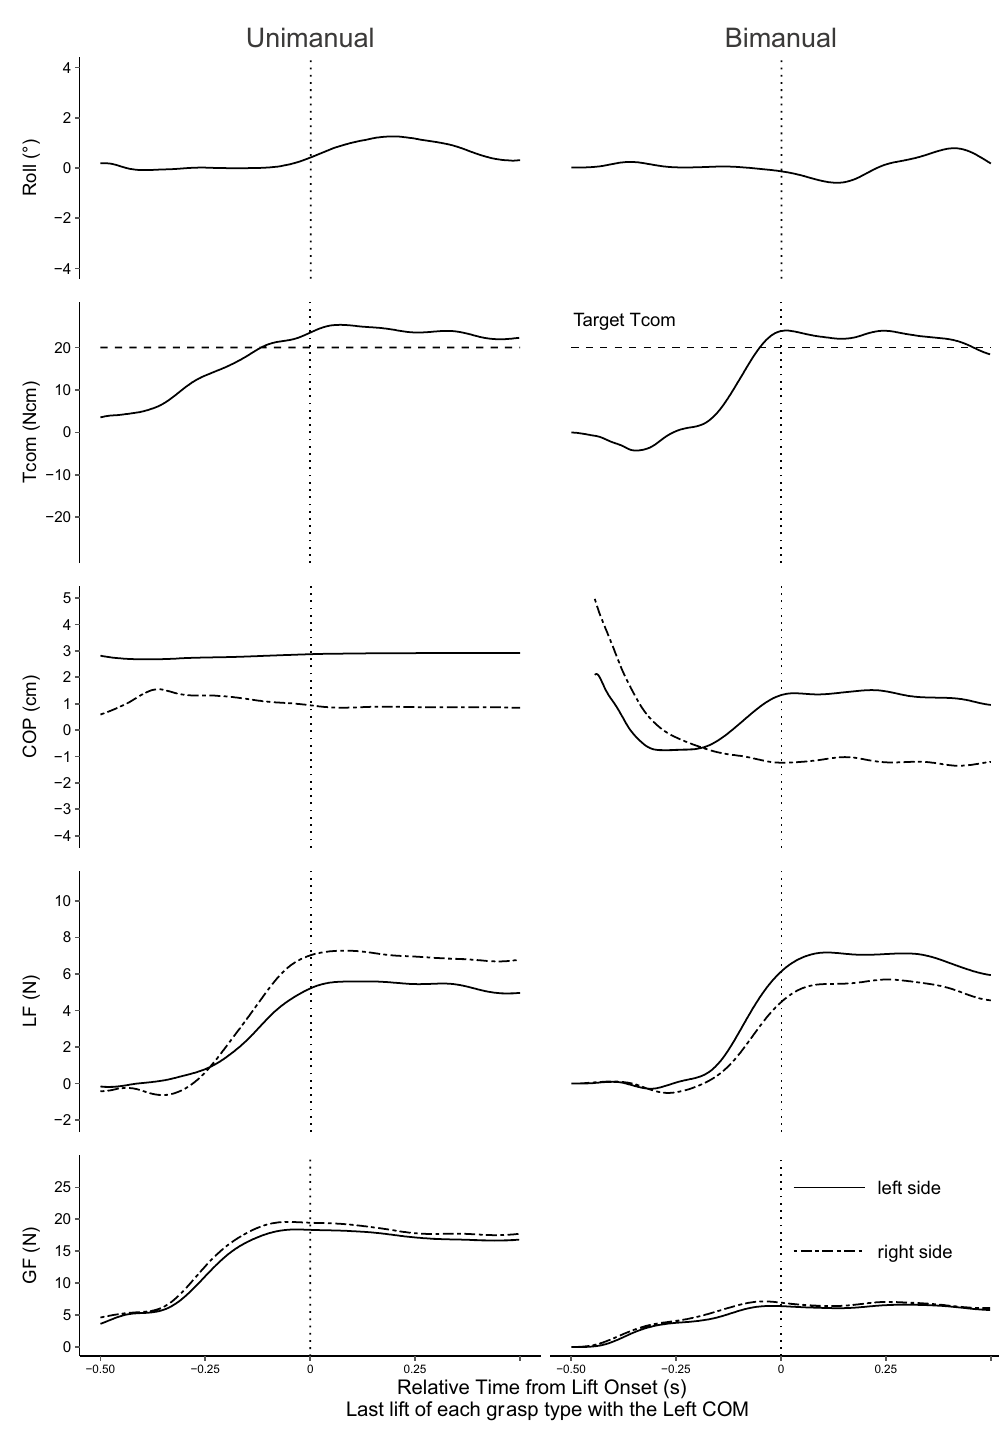
Figure 2. Representative plots for the left center of mass (COM). Traces for the learned trials of all measures for the unimanual and bimanual grasps. Tcom = compensatory torque, COP = center of pressure, LF = load force, GF = grip force. Vertical dotted lines represent time at lift